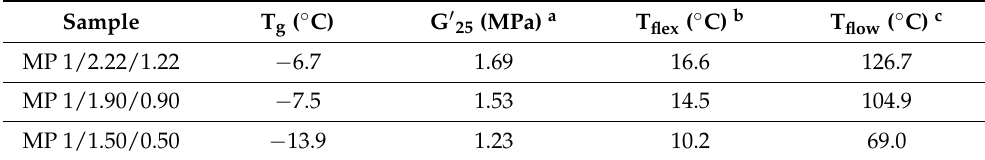
Table 7. Summary of the dynamic mechanical analysis results for the bio-based SMTPUs.